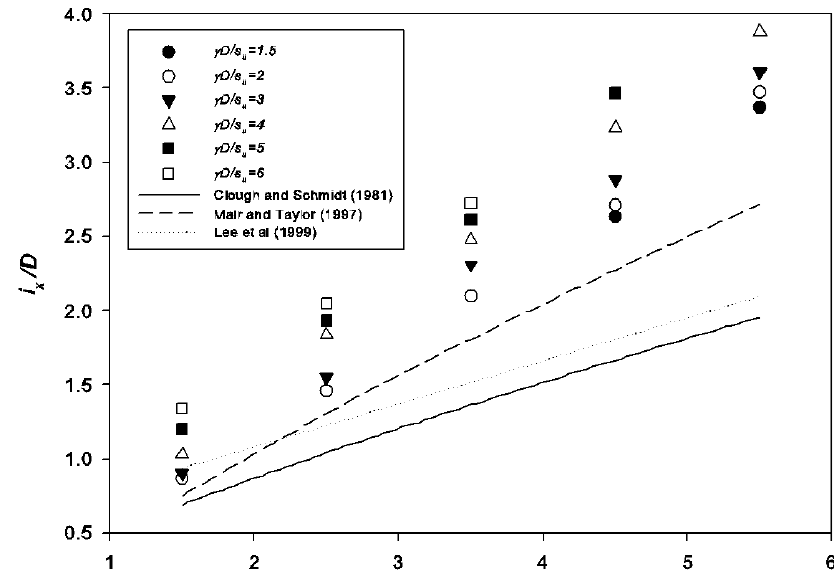
Figure 21. Comparison of results with other suggested equations.